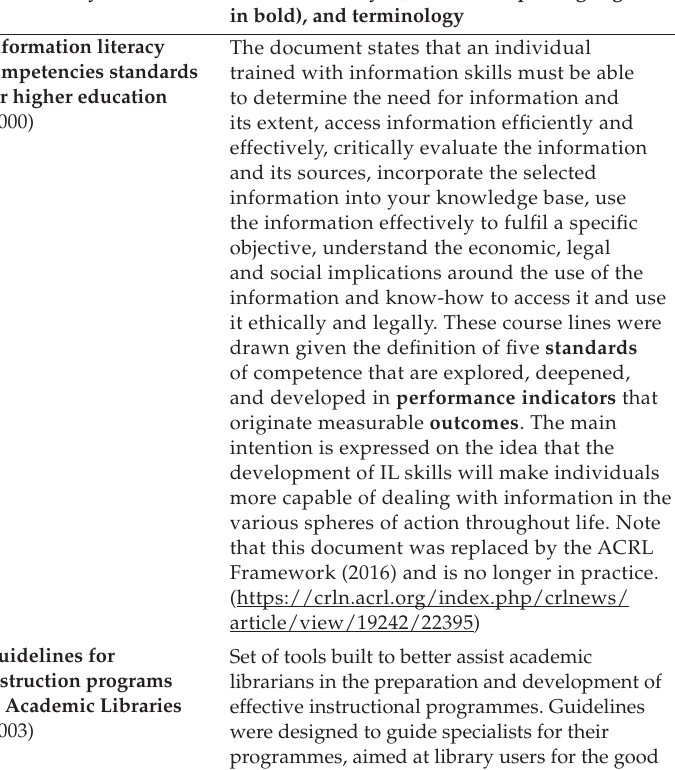
Table 1: Information Literacy: reference documents for teaching models.